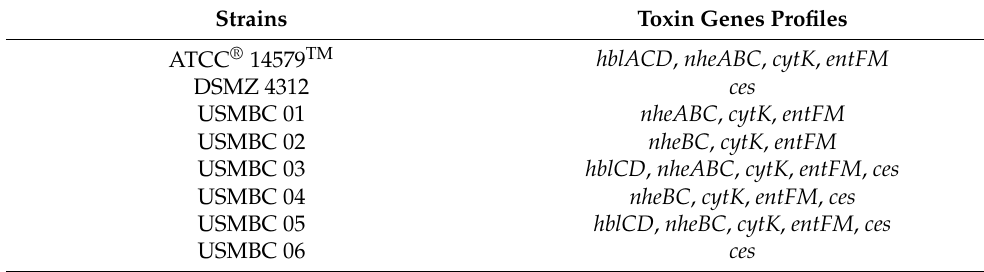
Table 1. Toxigenic profiles of the B. cereus strains used in this study. Strains Toxin Genes Profiles ATCC ® 14579